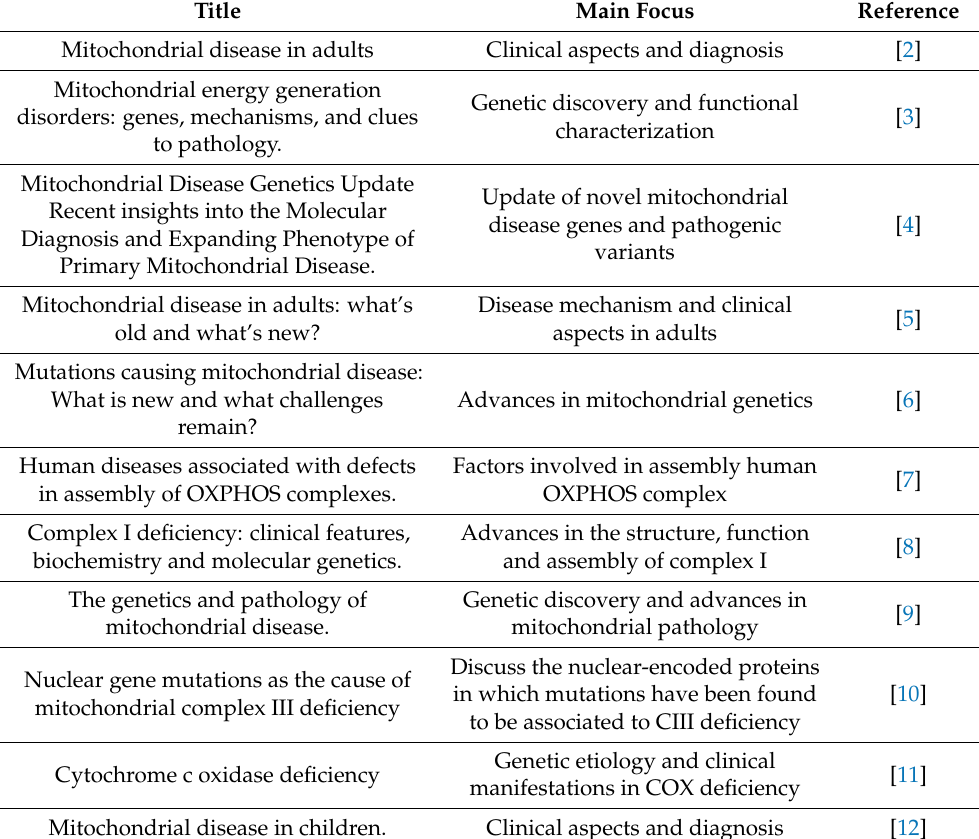
Table 2. Examples of reviews focusing on different aspects of mitochondrial disorders in the last